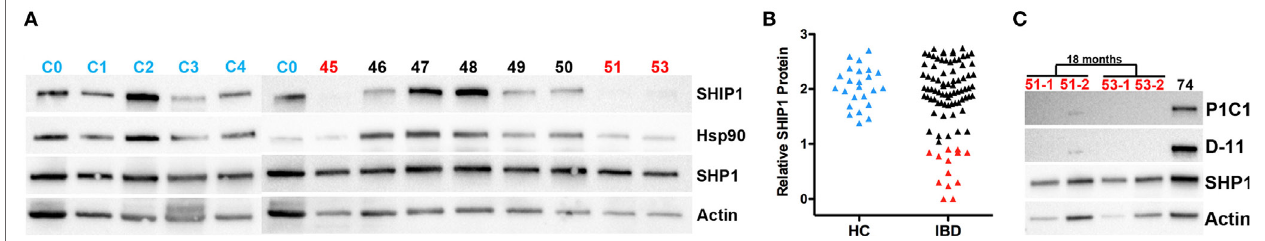
FigUre 1 | SHIP1 protein for a subset of the 89 samples quantified from the University of California San Francisco/San Francisco Veteran’s Affairs cohort. (a) Western blots for SHIP1 (P1C1, Santa Cruz), β -actin, SHP1, and heat shock protein 90 (Hsp90) on a subset of inflammatory bowel disease (IBD) patient lysates (45–53, in black for SHIP1-sufficient and red for SHIP1-deficient samples as determined in B), HC samples (C1–C3, in blue) and the standard control C0. The C0 sample, pooled from equal amount of protein from all 24 HCs samples, was run with each Western blot to quantify relative SHIP1 expression levels in each sample. (B) Log10 of quantitative Western blot values of SHIP1 normalized to beta-actin as compared to C0 (arbitrarily set to 100% = 10 2 ). HC samples are shown in blue, and the SHIP1 deficiency threshold was set at 10% (10 1 ). SHIP1-sufficient IBD samples are in black ( n = 76) and SHIP1-deficient samples, displaying less than 10% of SHIP1 in C0, are shown in red ( n = 13). (c) Lysates prepared from PBMC from SHIP1-deficient patients (51-2 and 53-2) taken 18 months after the initial blood draw was probed in parallel to an aliquot of the initial samples (51-1, 53-1) and a SHIP1-sufficient sample. This has been confirmed in several SHIP1-deficient patients. Western blots were also re-probed with different antibodies against SHIP1 (D1163, Cell Signaling Technologies, not shown and D-11, Santa Cruz) that recognize distinct epitopes on the